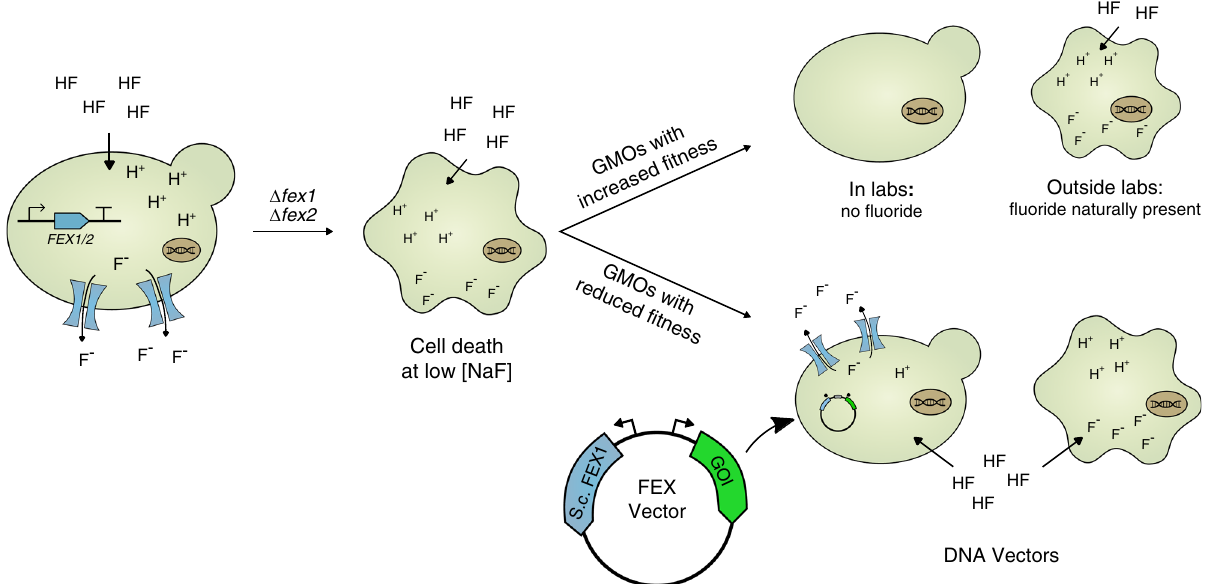
Fig. 1 Engineered fl uoride sensitivity augments biocontainment and selection systems. Yeast cells lacking native fl uoride exporter genes ( FEX1/FEX2 ) are highly sensitized to low concentrations of fl uoride yet retain wildtype phenotypes in the absence of the ion. Accordingly, this mechanism be fi ts biocontainment of genetically modi fi ed organisms (GMOs) that pose ecological risks outside of laboratory environments. Alternatively, fl uoride sensitivity can be leveraged to provide an alternative selection marker in GMOs with reduced fi tness and likelihood of persistence in the